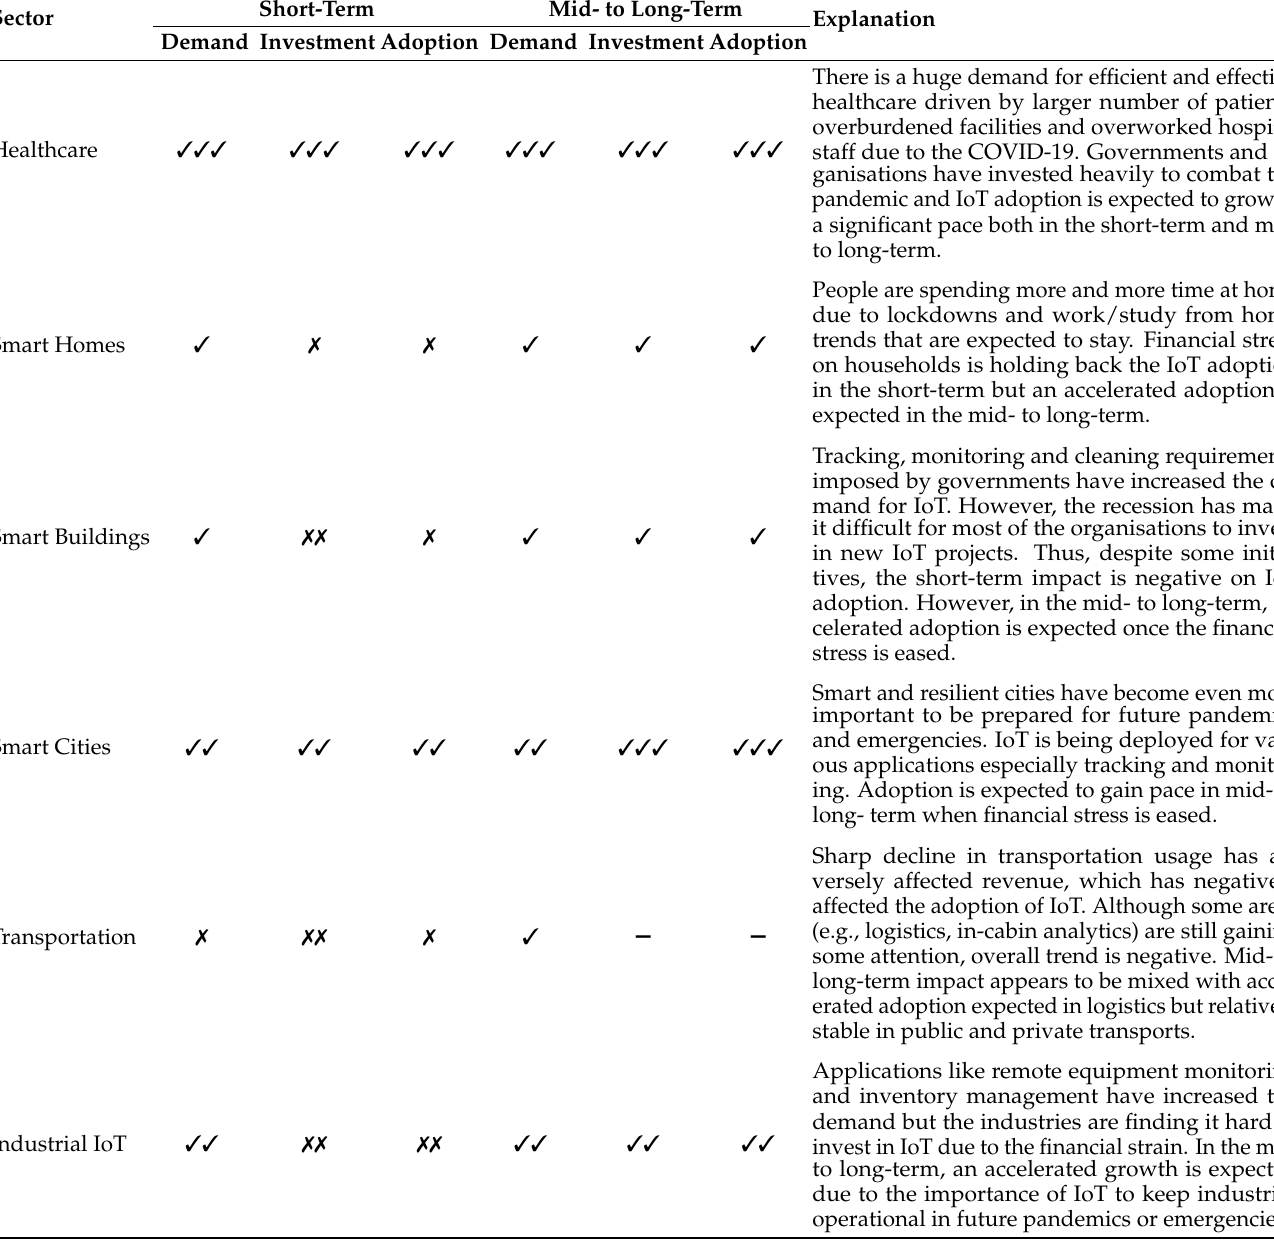
Table 3. Our prediction of the COVID-19’s impact on IoT adoption in short-term and mid- to long-term. (cid:51) indicates accelerated adoption, (cid:55) indicates decelerated adoption, and – indicates that the adoption is both positively and negatively impacted in different subareas. Number of (cid:51) and (cid:55) indicate how strong the positive and negative impacts are expected to be, respectively. Sector Short-Term Mid- to Long-Term Explanation Demand Investment Adoption Demand Investment